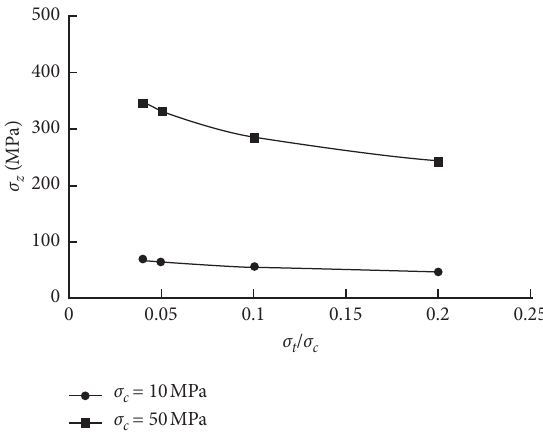
Figure 12: Correlation between bearing capacity and σ